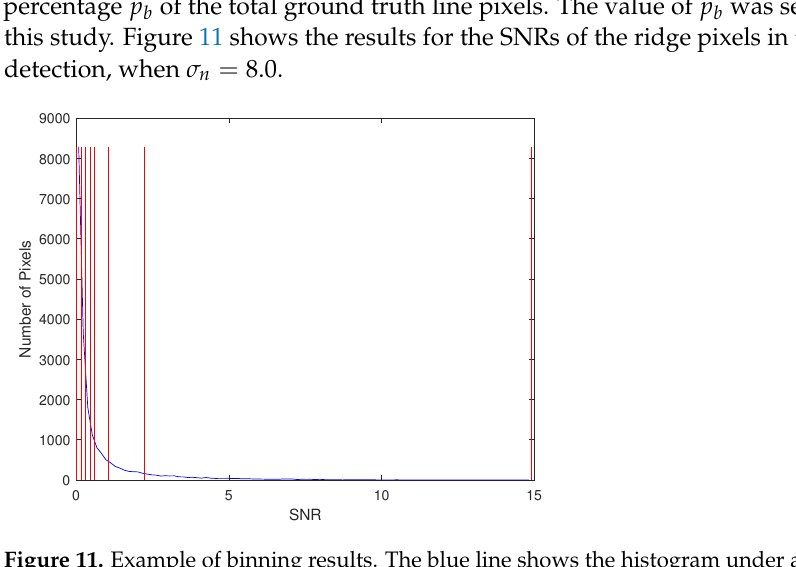
Figure 11. Example of binning results. The blue line shows the histogram under a given bin size and the red lines the boundaries of the new